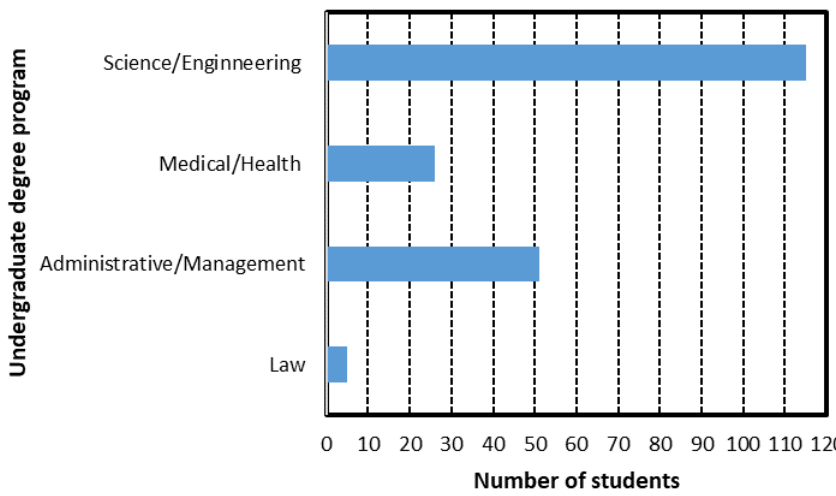
Figure 3. Distribution of the student sample by degree program: Science and Engineering, Medical/Health, Administrative/Management, and Law studies.